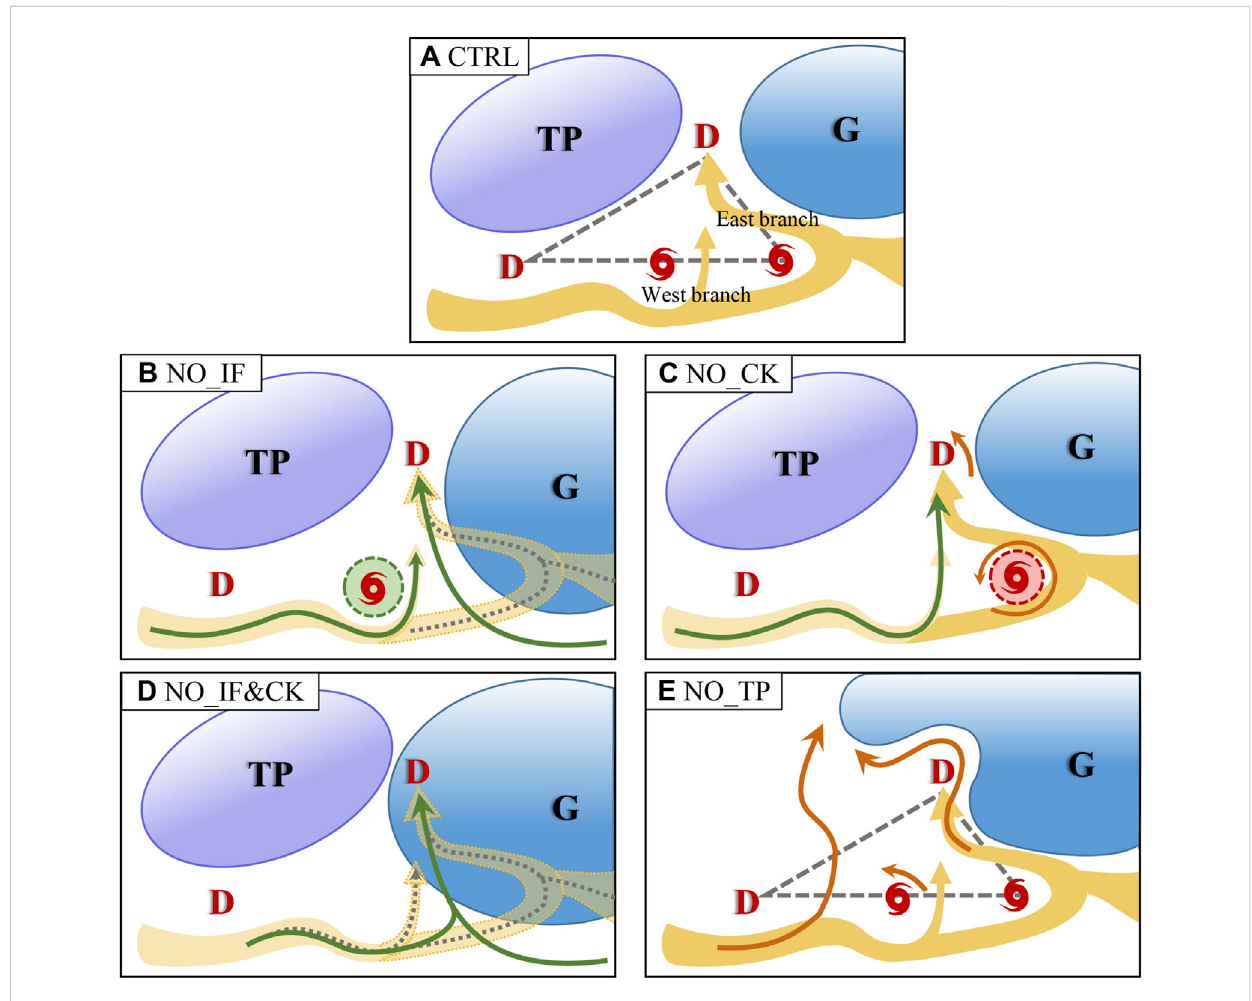
FIGURE 11 Conceptualmodel of water vapor transport during theextreme rainstormin Henan undermulti-system con fi guration (A) CTRL (B) NO_CK (C) NO_ IF_Lev3 (D) NO_IF&CK (E) NO_TP. “ G ” representsthesubtropicalhighand “ TP ” representsthelargeplateauterrain. “ D ” andtyphoonmarkscorrespondto low-pressure water ” vapor vortexes and typhoons, respectively. The thick yellow arrows represent the main water vapor transport branches, and yellow color depth represents changes in strength. Thin green and orange arrows represent weakened and increased water vapor fl ow directions. Grey dotted lines represent the disappearance of the water vapor branches. The colored areas surrounded by green and red dashed lines represent the weakening and strengthening of the cyclone,